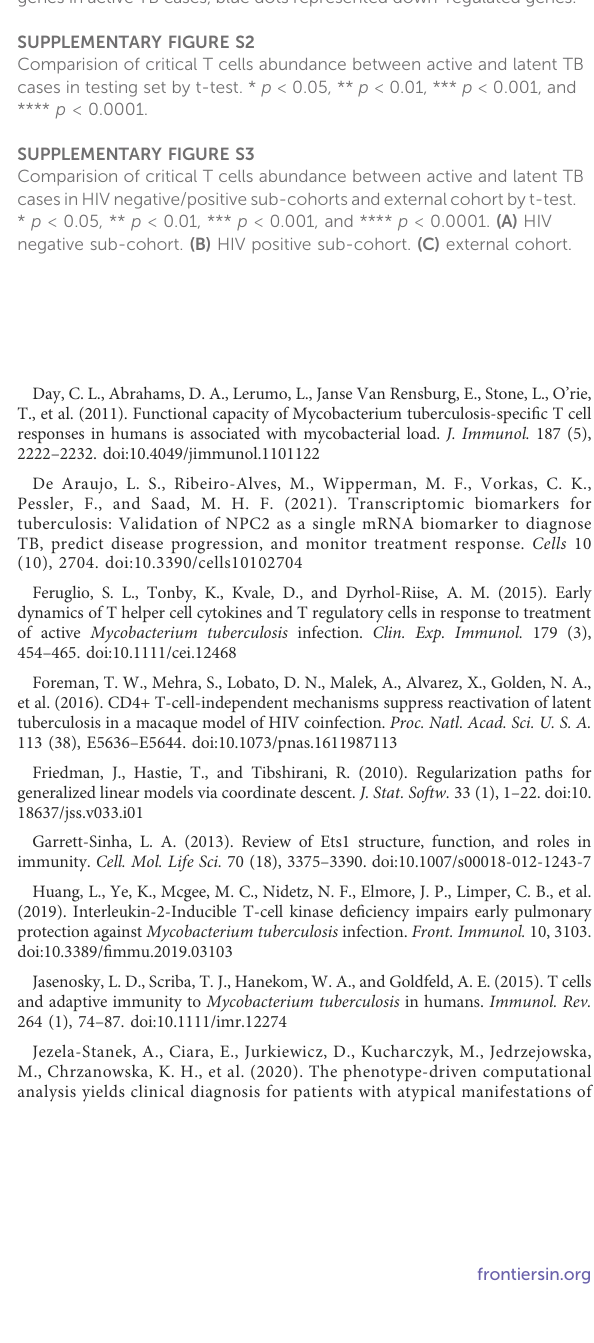
SUPPLEMENTARY FIGURE S1 Volcano diagram of DEGs in training. Red dots represented up-regulated genes in active TB cases, blue dots represented down-regulated genes. SUPPLEMENTARY FIGURE S2 Comparision of critical T cells abundance between active and latent TB